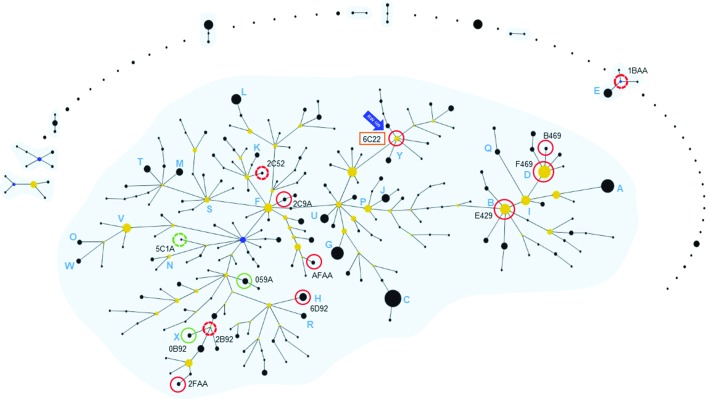
Industrial
P. aeruginosa
 strains are widely distributed across the AT genotype inferred population. The clonal complex structures of 1464 strains are shown, including strains from CF, other human infections and environmental sources, as well as 1446 strains analysed by Wiehlmann et al. [17]. The industrial and efficacy testing
P. aeruginosa
 strains (Table S2) were analysed and placed within the inferred population as follows. Clonal complexes were calculated from the 16-marker AT genotype of the core genome by the eburst algorithm; the major
P. aeruginosa
 clonal complex and 8 additional groups have been highlighted with a blue background. AT genotypes are indicated by black, blue and yellow circles, with the diameter of the circle being proportional to the number of isolates with this genotype. Founding AT genotypes are shown in blue, subfounders are in yellow and prevalent clones are marked with light blue letters next to their corresponding AT genotype. The industry-associated
P. aeruginosa
 strains are marked with closed (previously reported AT genotypes) or broken (novel AT genotypes) red circles, and their AT genotypes are indicated (Table S2). The position of the industrial strain RW109 is highlighted by the blue arrow and the orange box-enclosed AT genotype.